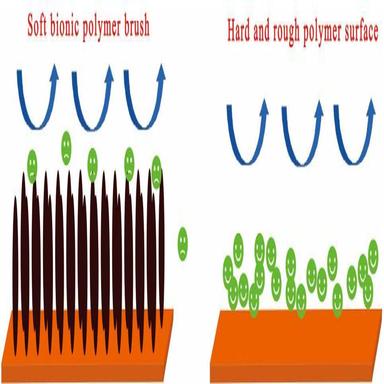
Topological model of bionic polymer brush.